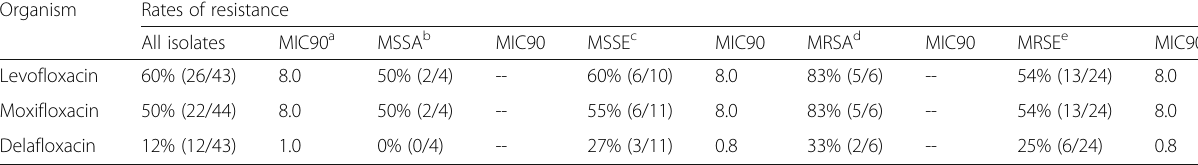
Table 1 Antimicrobial activities of delafloxacin, levofloxacin, and moxifloxacin tested against intravitreal Staphylococcus isolates Organism Rates of resistance All isolates MIC90 a